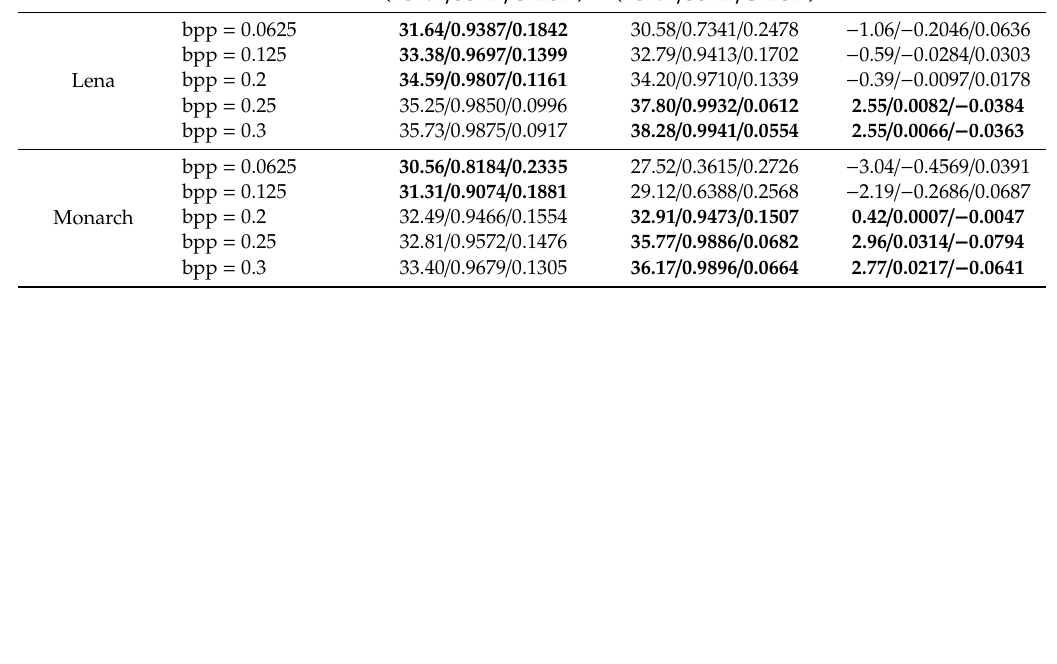
Table 5. The comparison results of different test-images under the various conditions (bits per pixel